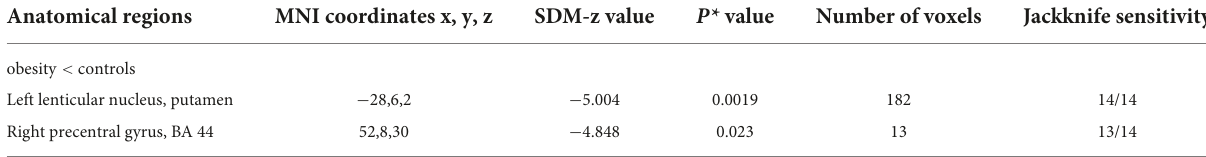
TABLE 2 Lower gray matter volume in subjects with overweight and obesity compared with controls in the meta-analysis. Anatomical regions MNI coordinates x, y, z SDM-z value P* value Number of voxels Jackknife sensitivity obesity < controls Left lenticular nucleus, putamen − 28,6,2 − 5.004 0.0019 182 14/14 Right precentral gyrus, BA 44 52,8,30 − 4.848 0.023 13